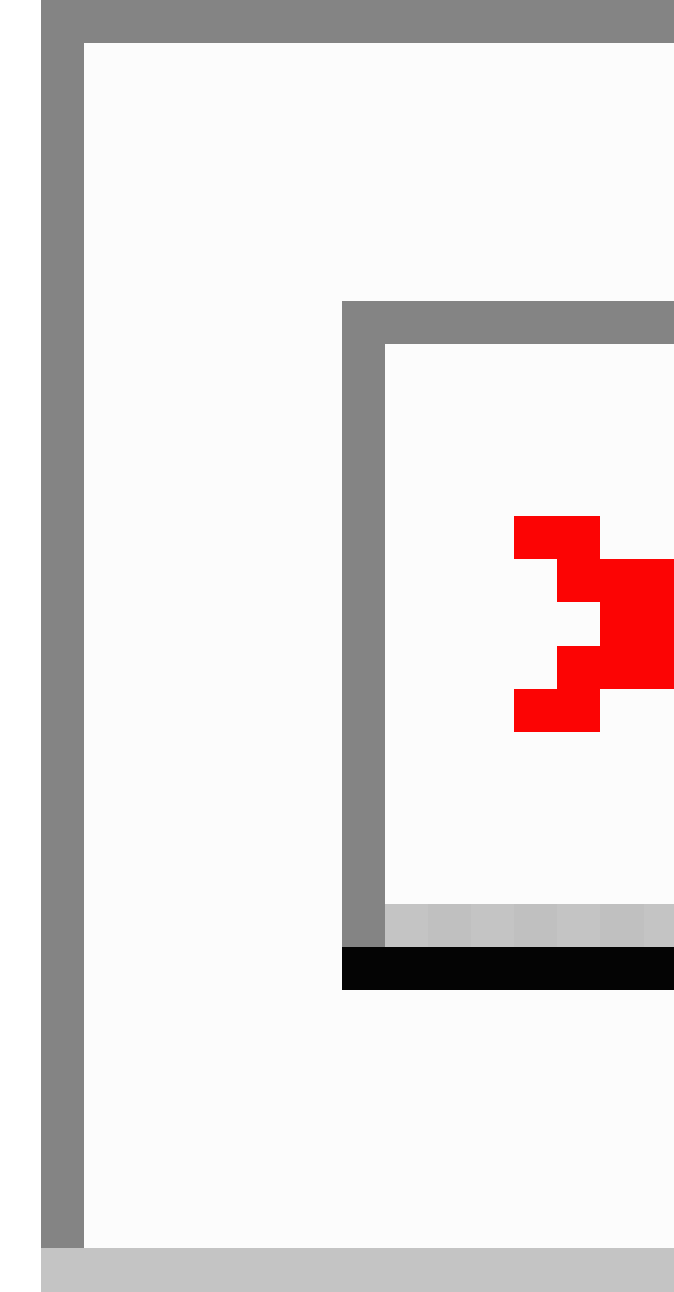
Figure 2 provides insight in the reliability of the nine missing data approaches. The white dots in this figure show the arithmetic mean of the 75 bootstrapped samples. The area between the two dashed horizontal lines corresponds to the 95% confidence interval of the reference value. Each black dot indicates the arithmetic mean of one of the bootstrapped samples. As in Figure 1, some horizontal jitter was added to improve the visual presentation of the plotted